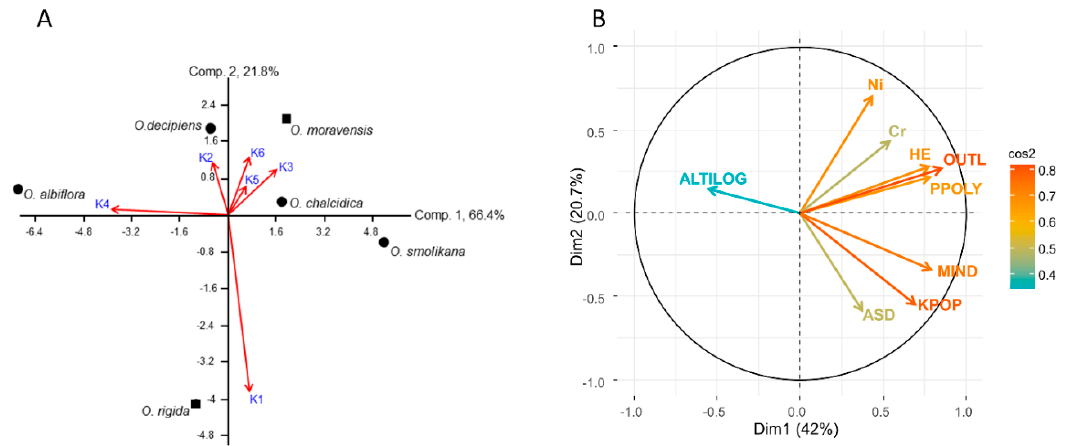
Figure 3. ( A ) Principal component analysis biplot showing relationships between the six genetic groups (K; numbers as in Figure 2A and the six Albanian taxa of Odontarrhena (dots are diploid taxa, squares are tetraploids); ( B ) Scattergram from multifactorial analysis showing the direction of variation of the number of genetic groups per population (KPOP), genetically admixed individuals (MIND), number of outlier loci (OUTL) and heterozygosity HE in relation to anthropic site disturbance (ASD), altitude (ALTILOG), and Ni and Cr soil concentration. The cos2 values, represented in the color scale barplot, show the contribution of the variables on both dimensions (Dim 1 and Dim 2). Table 2. Main parameters of genetic diversity in Albanian populations and taxa of Odontarrhena : number of genetic groups (reaching a proportion of at least 10%) in each population (KPop) and number of genetically admixed individuals (Mind), number (no. poly) and percentage (%poly) of polymorphic loci; population heterozygosity ( H e ), mean species heterozygosity ( H s ), mean number of outlier loci per population (Out) and mean genetic distance between populations within taxa ( F ST ). Taxa / Taxa/Pop.